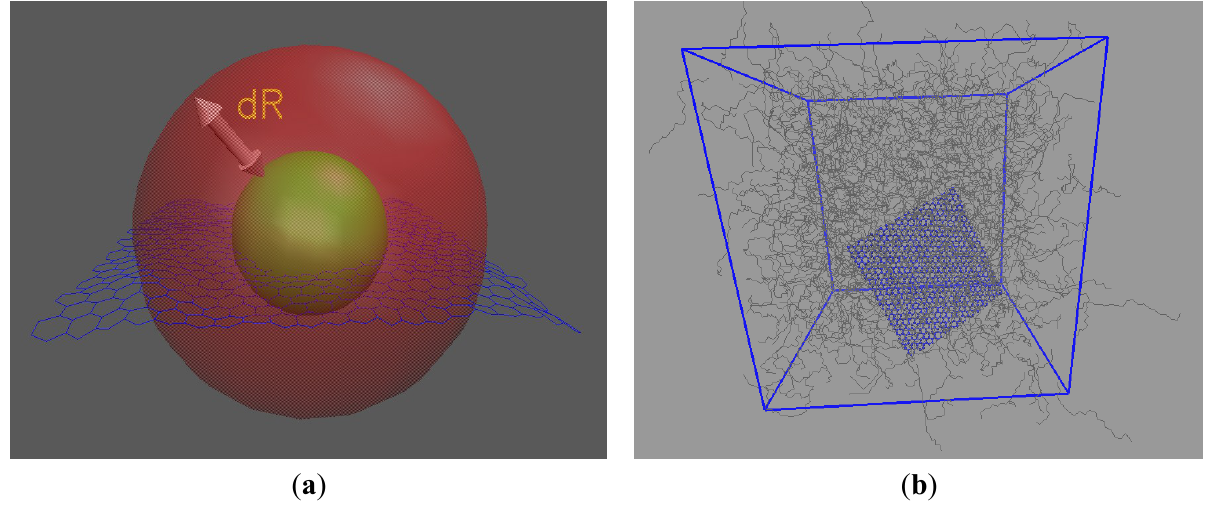
Figure 1. ( a ) A sketch of the analysis scheme in spherical shells; ( b ) A Snapshot of a model polyethylene/graphene system at 450 K. Graphene layer of size (49 × 51) Å 2 . Additional videos from the simulations can be found in the supplementary